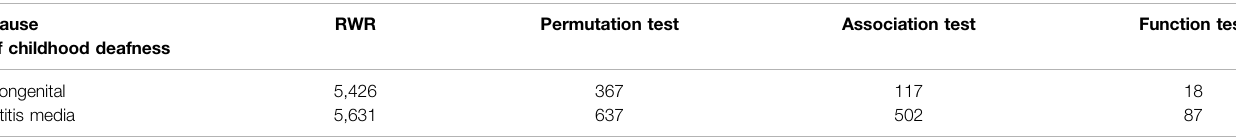
TABLE 1 | Numbers of candidate genes remaining after each fi ltration